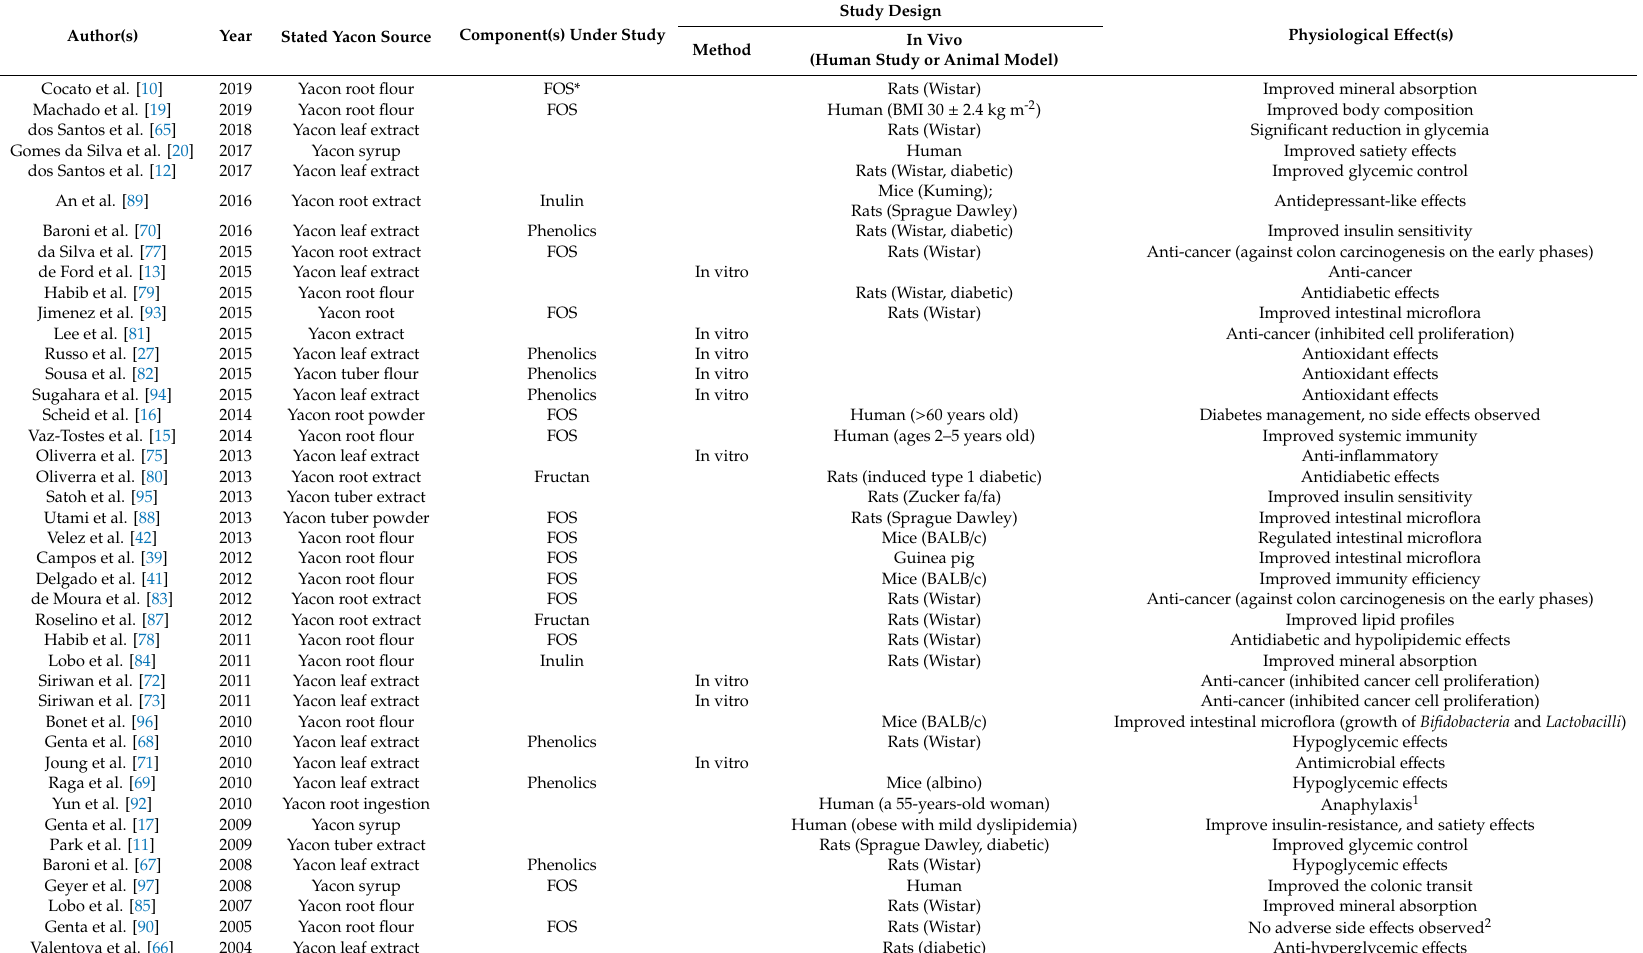
Table 1. Summary of studies on yacon ( Smallanthus sonchifolius ) in vitro and in vivo in human or animal models.